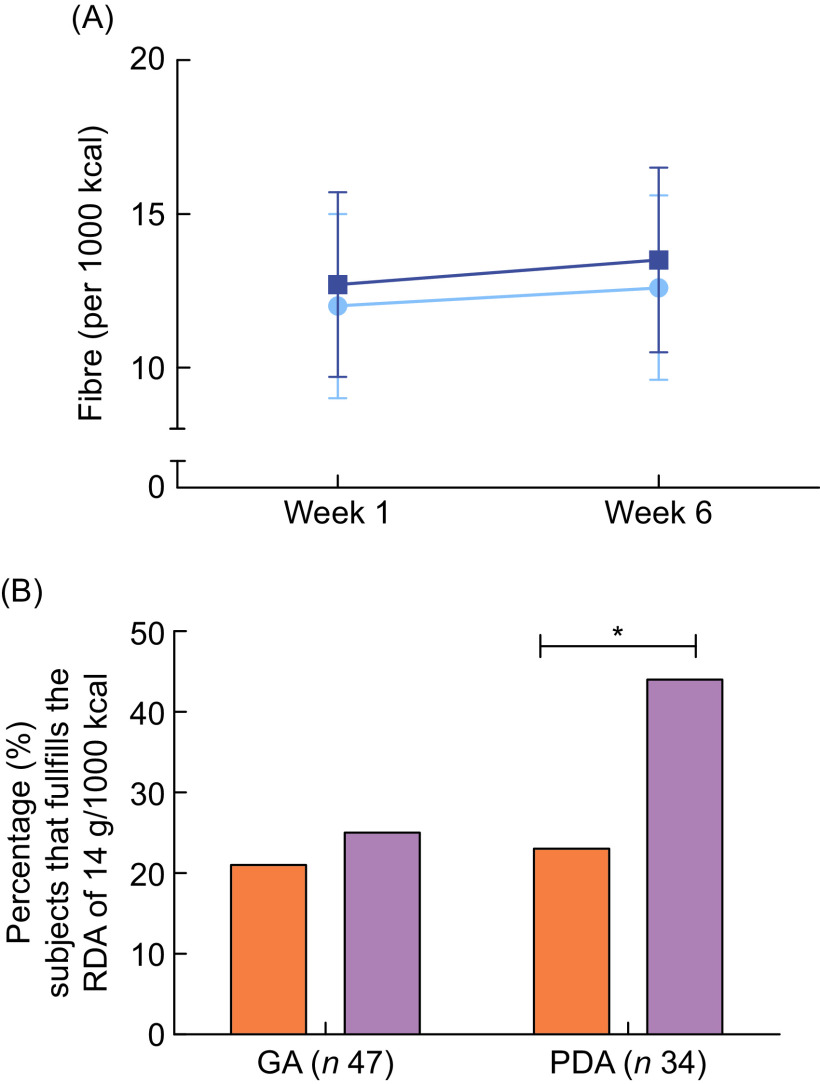
(A) Dietary fibre intake (per 1000 kcal) did not change during the 6-week intervention. Data are based on 24-h recall recalls. Error bars represent standard errors. , general advice (GA) (n 47); , personalised dietary advice (PDA) (n 34). (B) Adherence to the fibre recommendation during the 6-week intervention is higher in the intervention group. Recommendation according the Dutch Health Council of 14 g of fibre/1000 kcal. , Week 1; , week 6. * indicates significant differences within the group